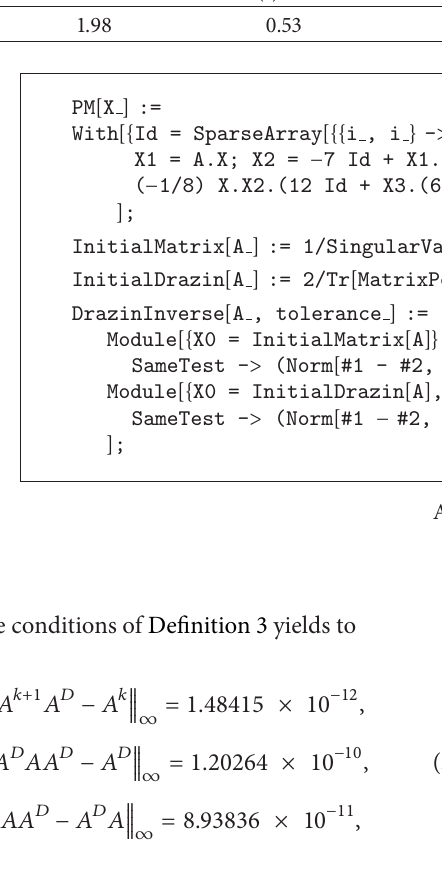
Table 4: Comparison of the computational time in solving the linear system resulting of discretization of (51) when 𝑛 = 2000 .